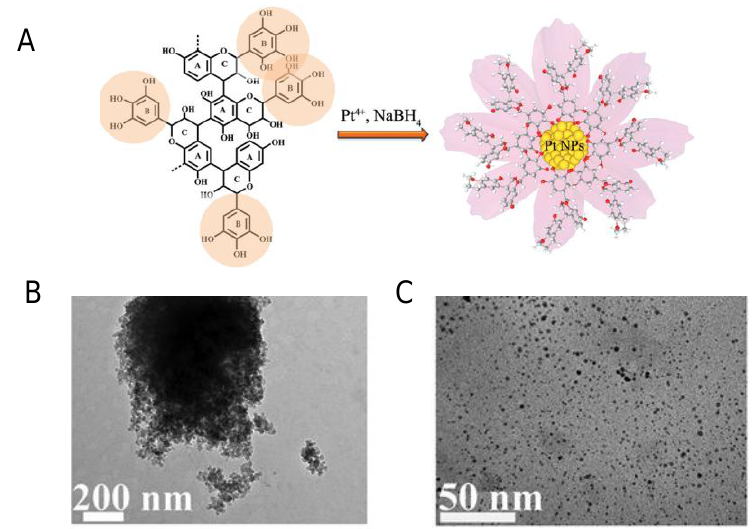
Figure 11. Synthesis of Pt nanoparticles induced by black wattle tannin (BWT). ( A ) Scheme of the formation of PtNPs by BWT; ( B ) TEM image of synthesized PtNPs using 2 mg of BWT; ( C ) TEM image of synthesized PtNPs using 15 mg of BWT. Reproduced with permission from [54]. Copyright the Royal Society of Chemistry, 2016.